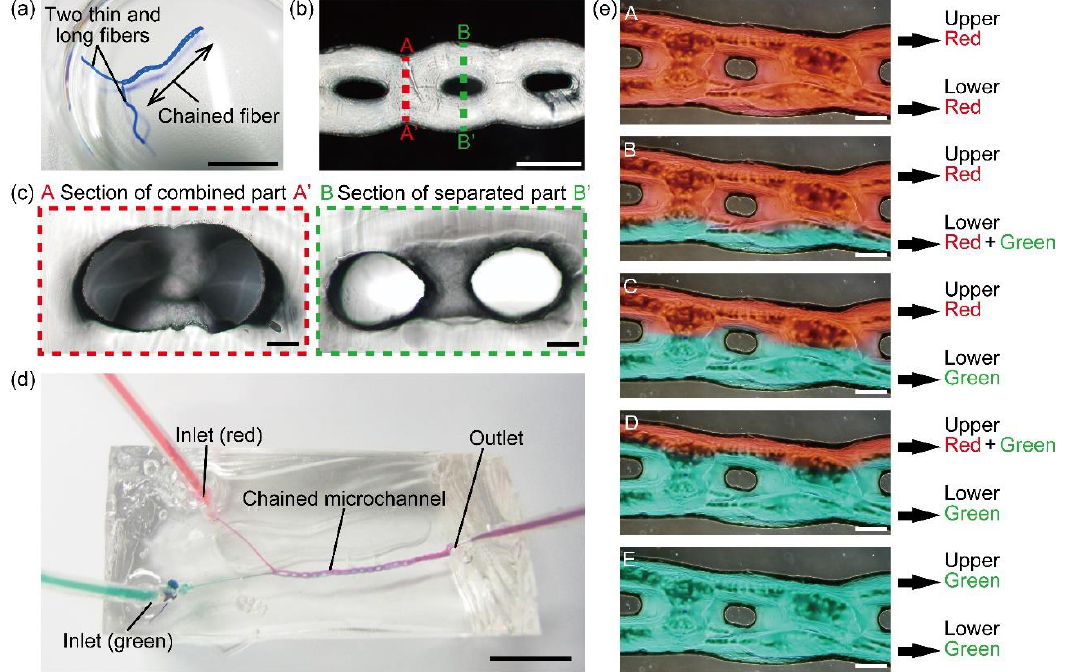
Figure 8. Chained PDMS microchannel fabricated with chained alginate microfibers. ( a ) Alginate microfiber with the structure that two thin and long fibers are connected to a chained fiber as a sacrificial template; ( b ) top view of the chained microchannel; ( c ) cross-sectional image of the microchannel shown in ( b ). Sections AA’ and BB’ are the combined and separated parts, respectively; ( d ) entire chained microchannel when infusing red and green solutions via different inlets; ( e ) flows of red and green solutions infused at A: 10 and 0, B: 8 and 2, C: 6.7 and 3.3, D: 5 and 5, E: 3.3 and 6.7, F: 2 and 8, and G: 0 and 10 mL/min, respectively. Scale bars are: ( a , d ) 1 cm; ( b ) 500 µm; ( c , e ) 100 µm.